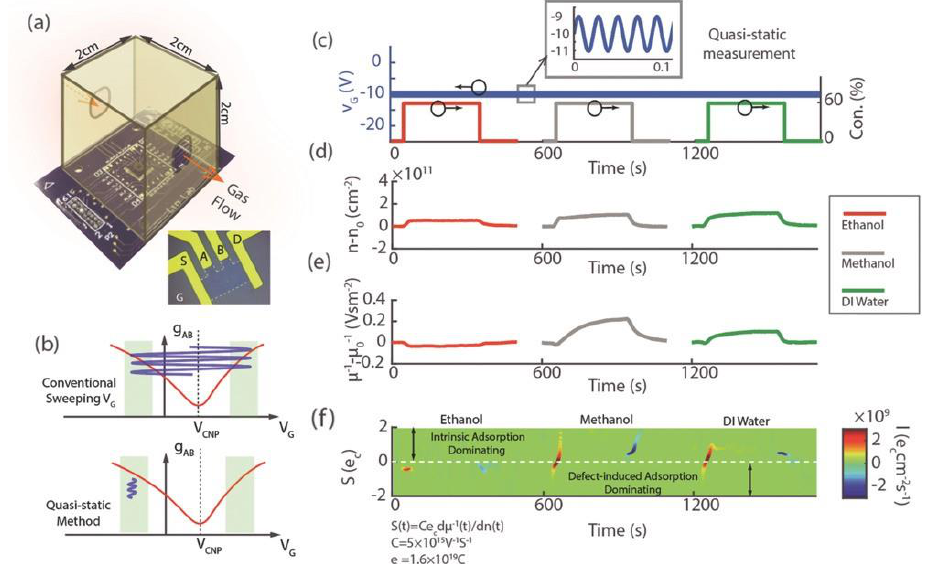
Figure 11. Quasi-static gate voltage method for observing the defect-induced gas adsorptions on a graphene transistor. ( a ) The graphene sensor inside the test chamber with a microscopic photo of the graphene transistor in the inset. ( b ) The schematic diagrams compare the conventional sweeping gate voltage VG and the quasi-static VG method, with the shaded area being the linear regions of the graphene transistor. ( c ) The time series of gate voltage and gas flow; zoom-in view of the gate voltage shown in the inset. ( d – f ) Real-time measured results of carrier density n(t), the inverse of field-effect mobility µ − 1 (t), and the scattering strength S(t) of gas adsorption and desorption on graphene using the quasi-static gate voltage, where n 0 = 2.0 × 10 12 cm − 2 , µ 0 − 1 = 4.0 V s m − 2 and e c = 1.6 × 10 −19 C is the elementary charge. Figure and caption taken with permission from Ref. [24]. Copyright by Wiley.